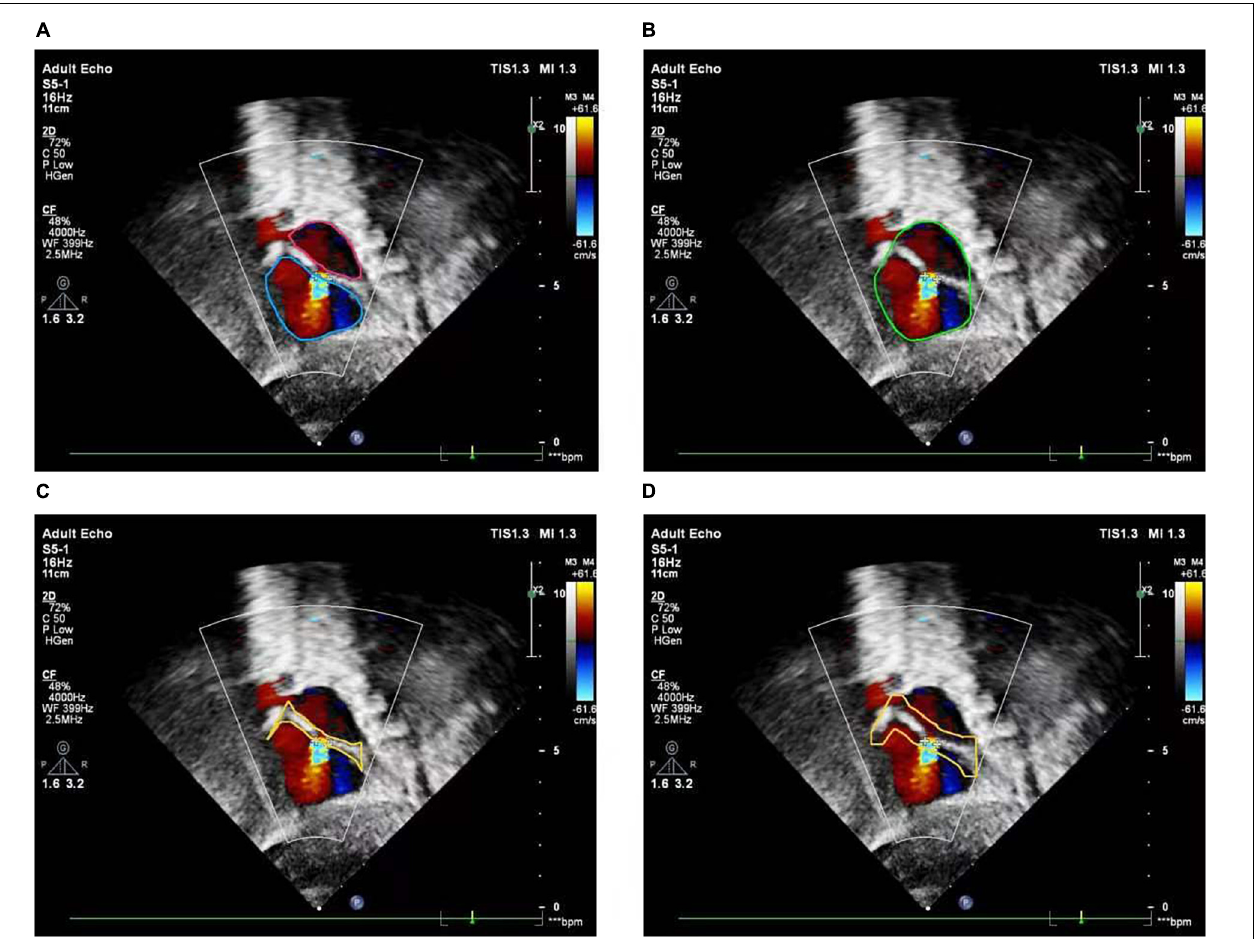
FIGURE 5 | Atrial septal region extraction. (A) Segmented left and right atria, (B) convex hull embracing segmented left and right atria, (C) region differences between (A) and (B) , (D) morphologically dilated atrial septum.